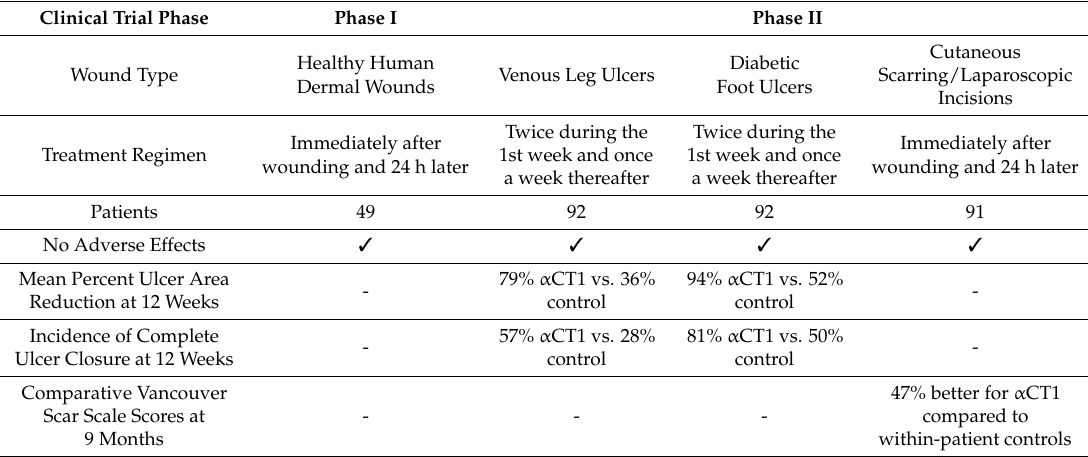
Table 1. Summary of completed alpha connexin carboxyl terminus 1 ( α CT1) clinical